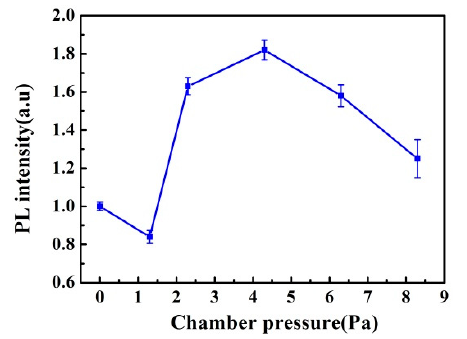
Figure 2. The influence of chamber pressure on PL intensity.